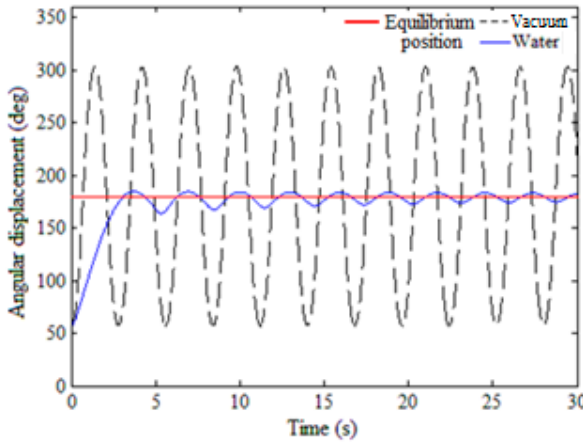
Figure 3. Time response of inverted pendulum systems without any oscillatory input.